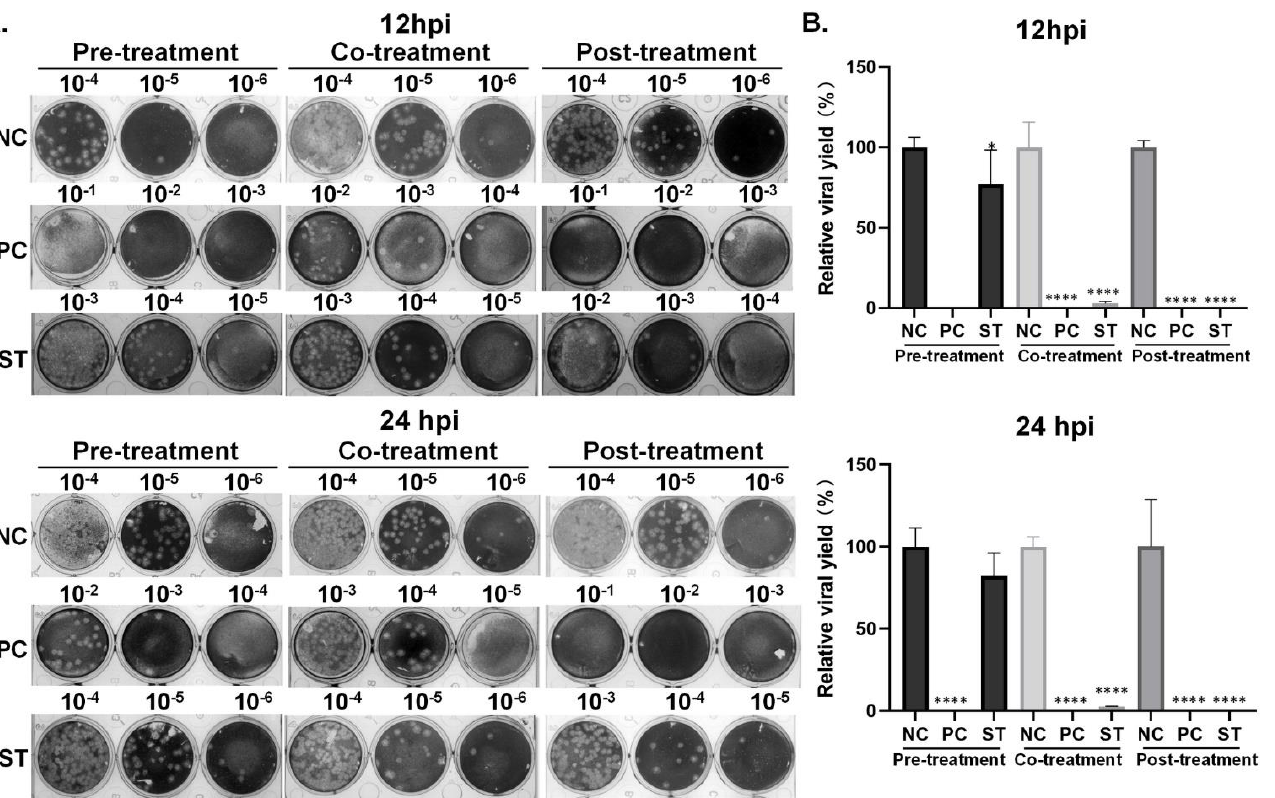
Figure 7. Effects of theacrine and remdesivir on MHV progeny production. ( A ) MHV infection of mouse L cells was 0.01 MOI/well. Mouse L cells were pre − , co − , or post − treated with 20 μM of remdesivir, as positive control (PC) or strictinin (ST ) of 100 μM. At 12 and 24 hpi, cell medium was harvested, and progeny production was estimated by the plaque assay of serial dilutions (indicated on top of the plates) of supernatants collected from infected cells. NC was a negative control group with only MHV. ( B ) Relative viral yield was calculated by using the plaque number in the NC group as 100%. All data were presented as mean ± S.D. ( n = 3). **** p < 0.0001, indicating significant difference from NC, was analyzed using one-way ANOVA, followed by